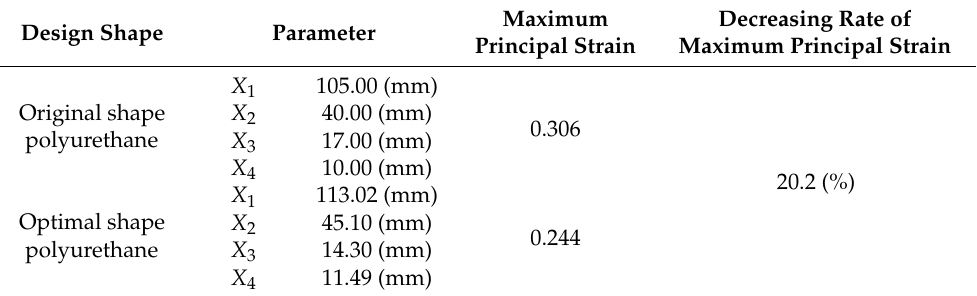
Figure 14. Result optimization of polyurethane spring: ( a ) MPS distribution of optimal design shape; ( b ) comparison of MPS histories among shape and material. Table 6. Comparison of variables and MPS between existing and optimum design shapes.